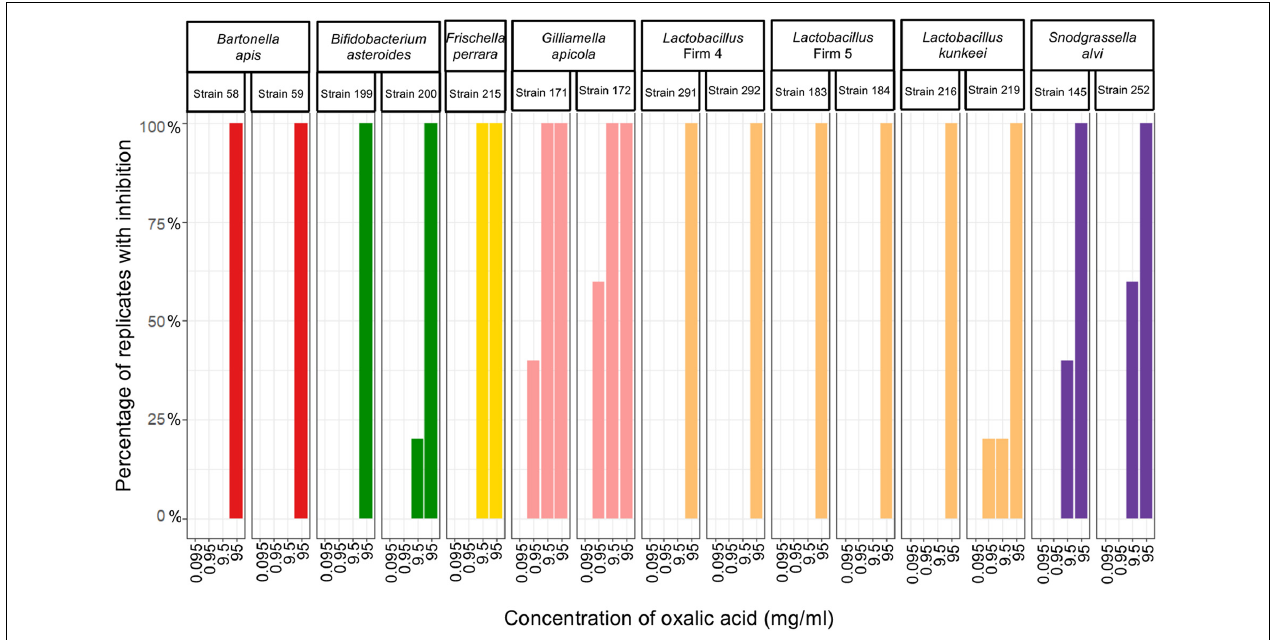
FIGURE 2 | Honeybee bacteria isolates inhibited by oxalic acid. The percentage of cultures that were inhibited after exposure to each of the four concentrations of oxalic acid ( n = 5 for all cultures, except for Lactobacillus Firm-4, strain 291, where n = 4 for 95 mg/ml and n = 3 for 9.5 and 0.95 mg/ml).